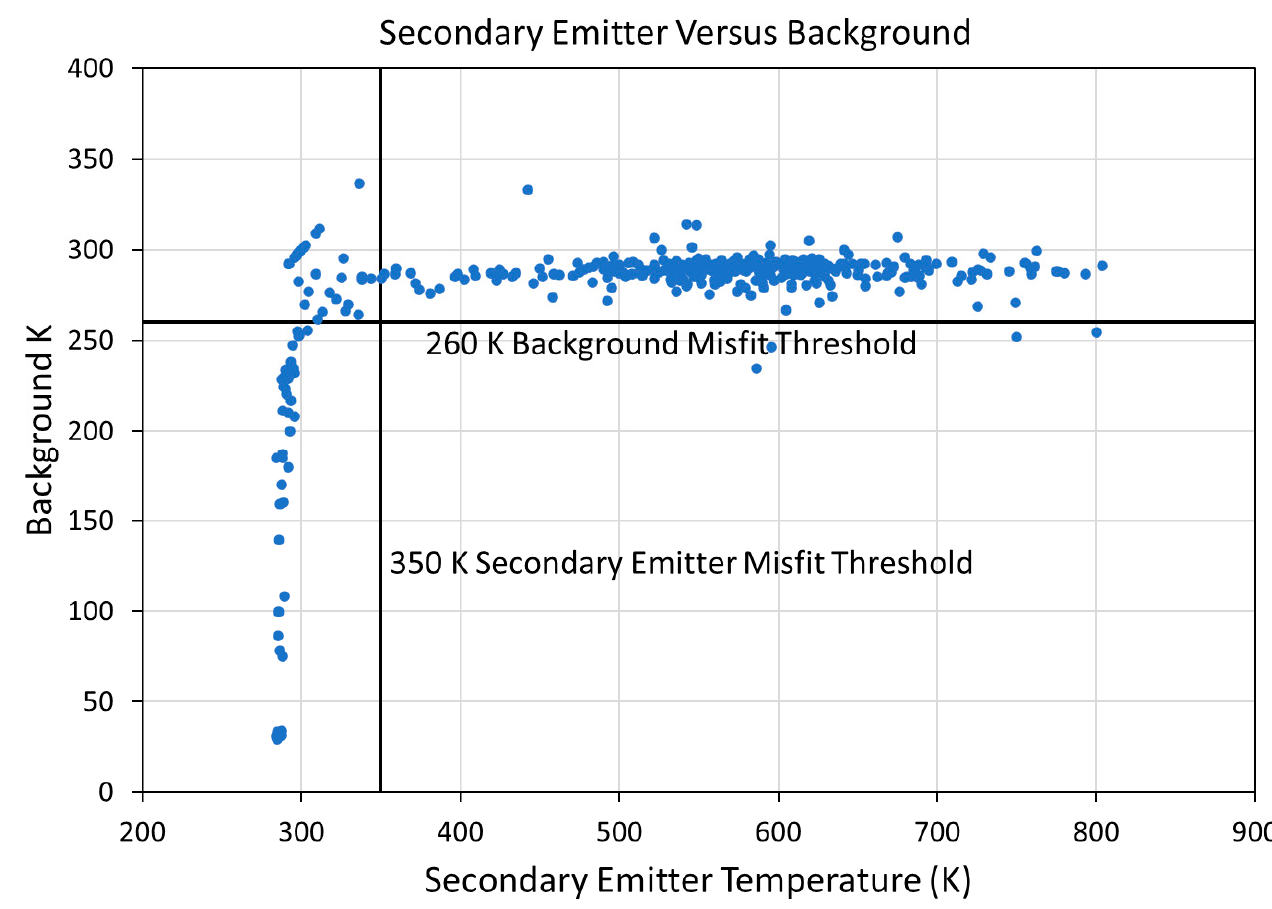
Figure 9. Scattergram of the unfiltered 2nd phase versus background temperatures from the three test sites. Secondary emitter temperatures below 350 K are associated with extremely large source areas fed by the incorporation of background radiance. The background size and temperature are forced down due to the loss of radiance to the secondary emitter. The misfit pixels are filtered out, relabeled as Type 5 and analyzed for a single IR emitter plus background.